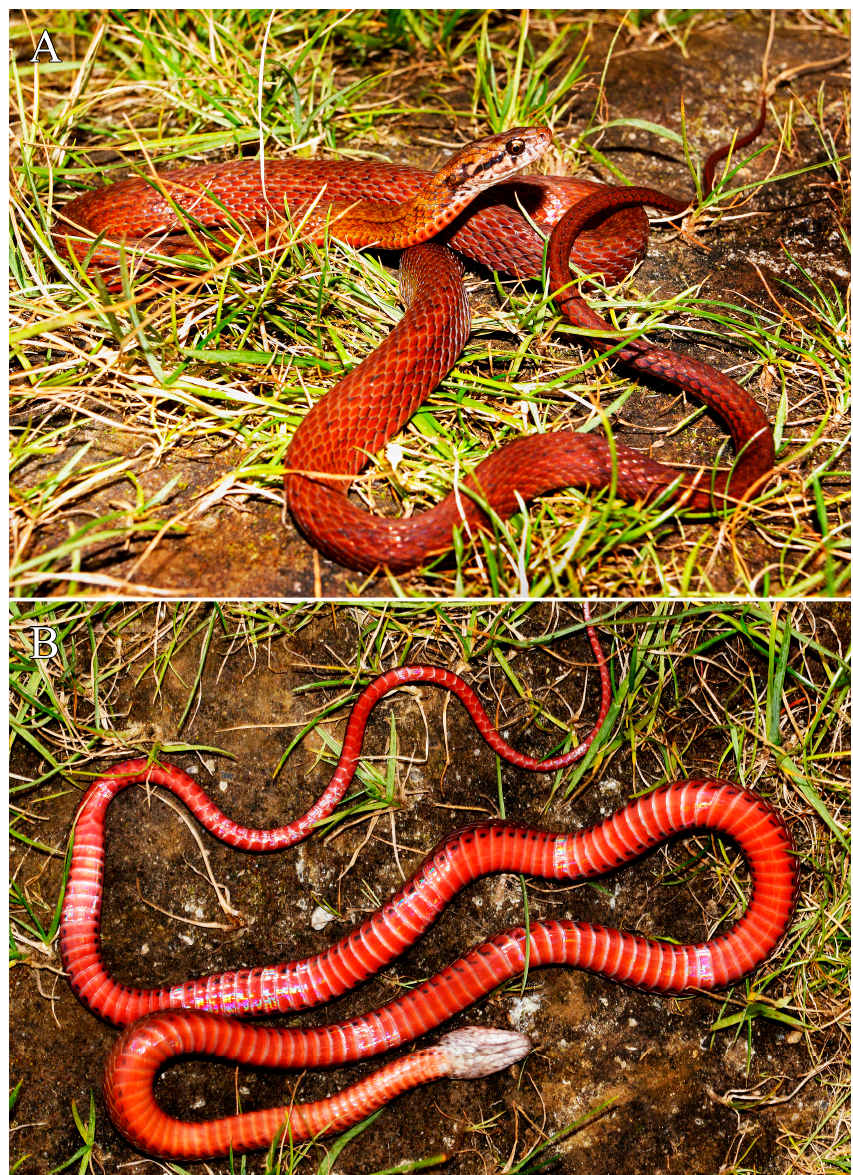
Figure 7. Herpetoreas tpser sp. nov. showing color in life, KIZ 06681, adult female, from 80K, M ê dog County, Xizang Autonomous Region, China. ( A ) dorsolateral view; ( B ) ventral view. Photographs by Mian